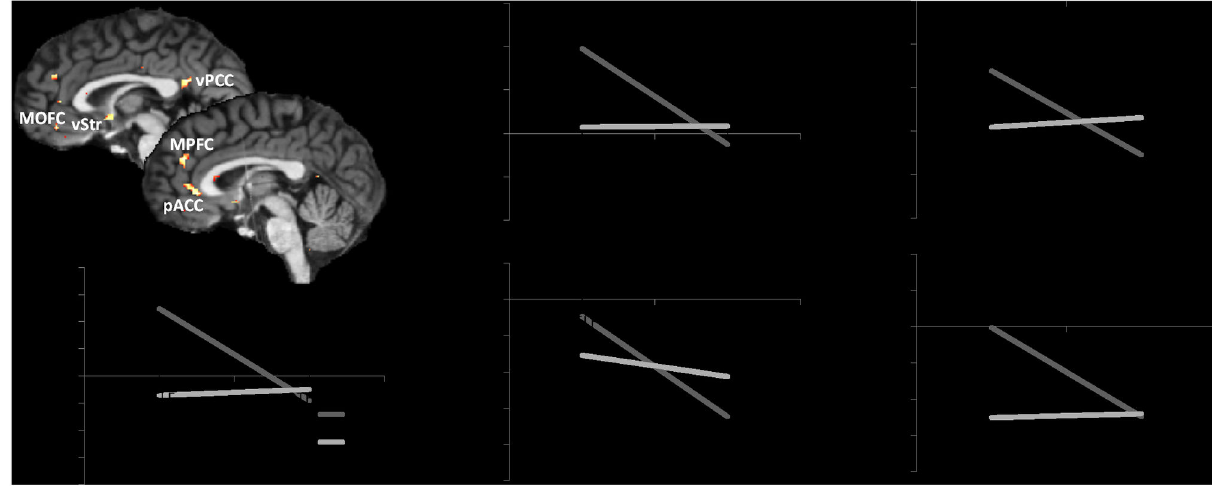
Figure 3. Interaction contrast of receiver and temporal distance (SELF [today-delay] – OTHER [today-delay]). Parameter estimates (including standard error) are displayed for illustration of the interaction effects only. Abbreviations: MOFC: medial orbitofrontal cortex; MPFC: medial prefrontal cortex; pACC: pregenual anterior cingulate cortex; vPCC: ventral posterior cingulate cortex; vStr: ventral striatum. doi: